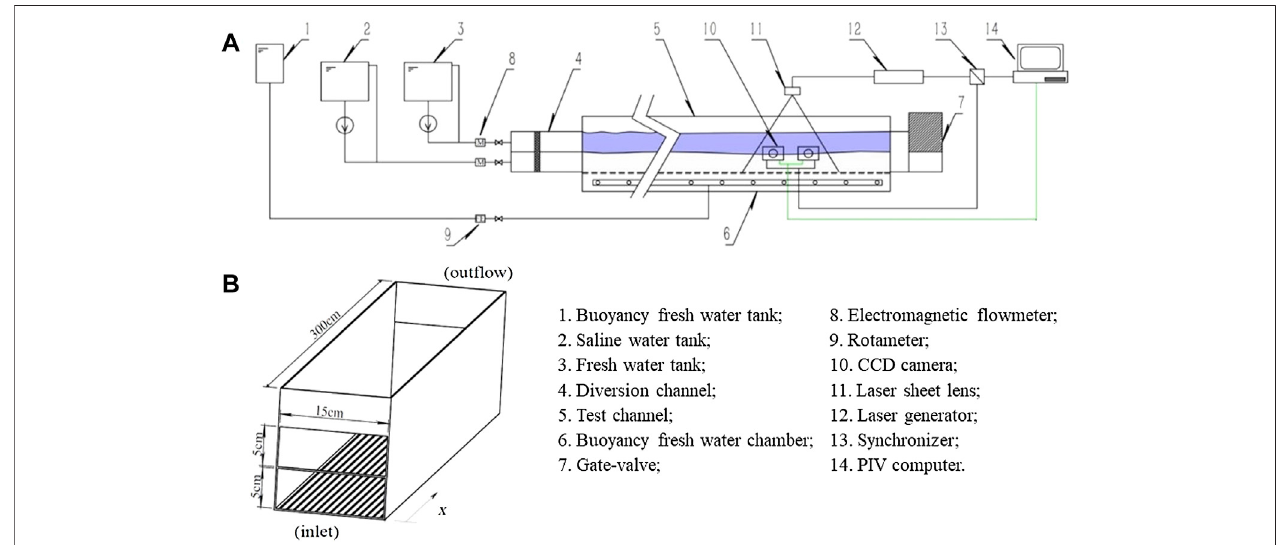
FIGURE 2 | Experimental strati fi ed fl ow fl ume setup and the PIV measurement system: (A) process fl ow diagram and (B) test channel structure.